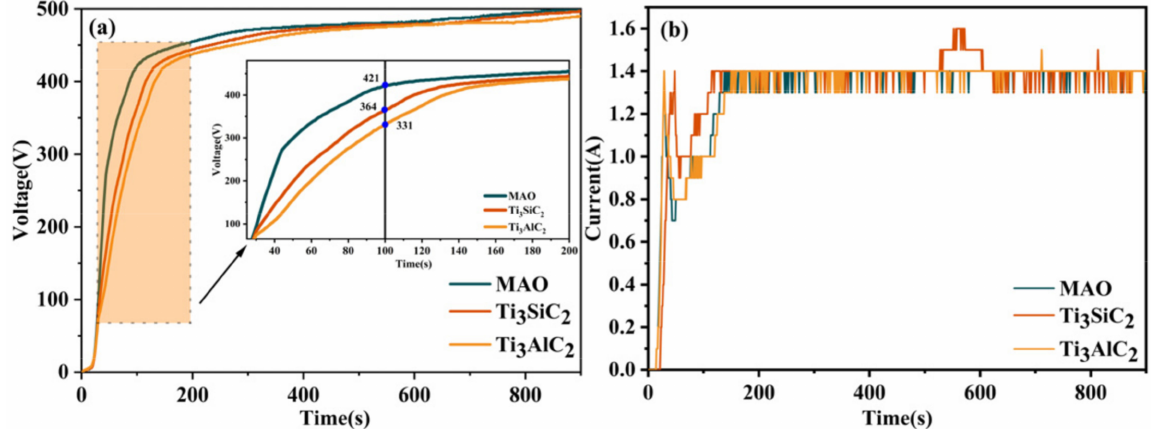
Figure 10. Voltage vs. current curves for MAO layers on TC4 alloys with different particle additions. ( a ) Voltage curve. ( b ) Current